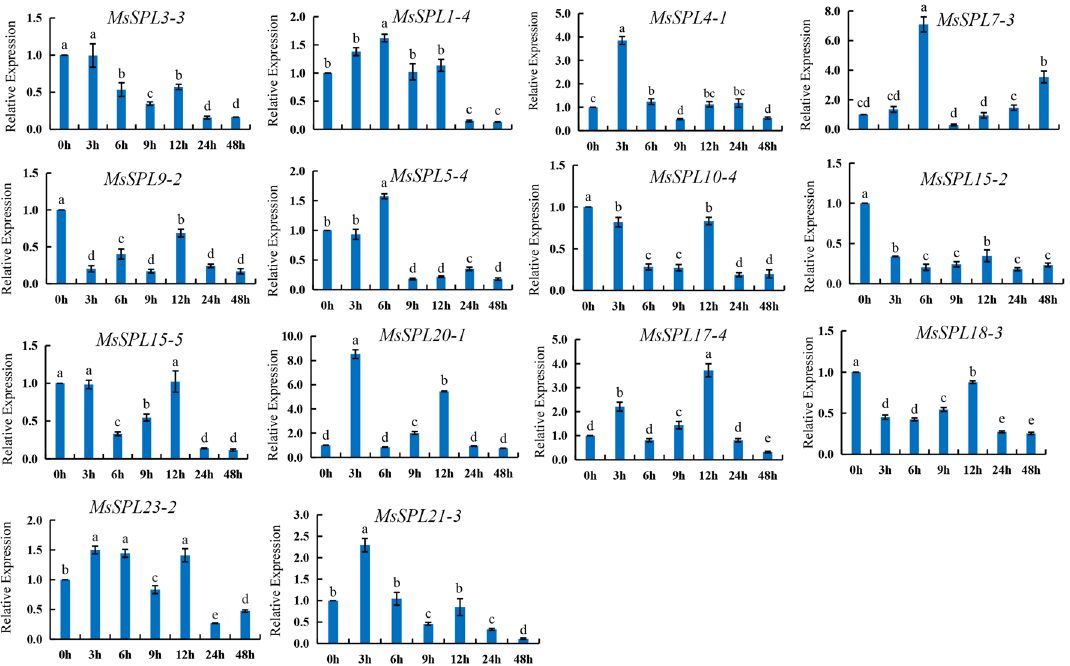
Figure 6. Gene expression of 14 MsSPL genes under drought treatment at 0 h, 3 h, 6 h, 9 h, 12 h, 24 h and 48 h was analyzed using qRT-PCR. Error bars represent standard errors of three biological replicates. The differernt lowercase letters indicate significant differences at the P < 0.05 level.